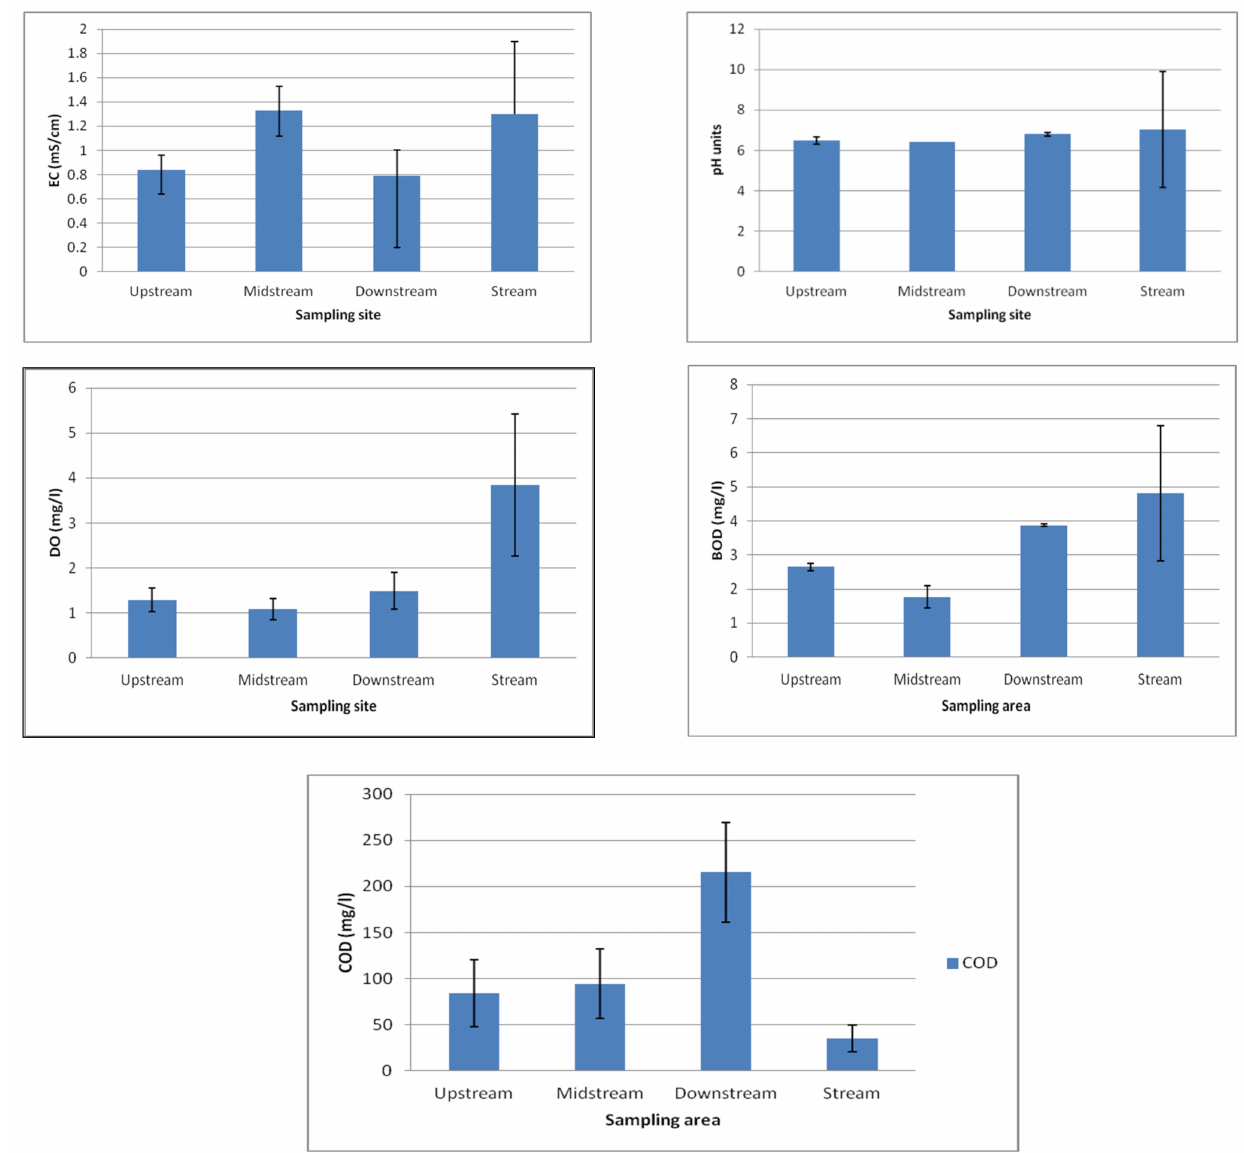
Figure 2. Averages of water quality parameters upstream to downstream of the wetland and the stream. The sodium and potassium levels in wetland water samples increased from upstream to downstream, whereas no pattern was observed for Mg and Ca concentrations (Figure